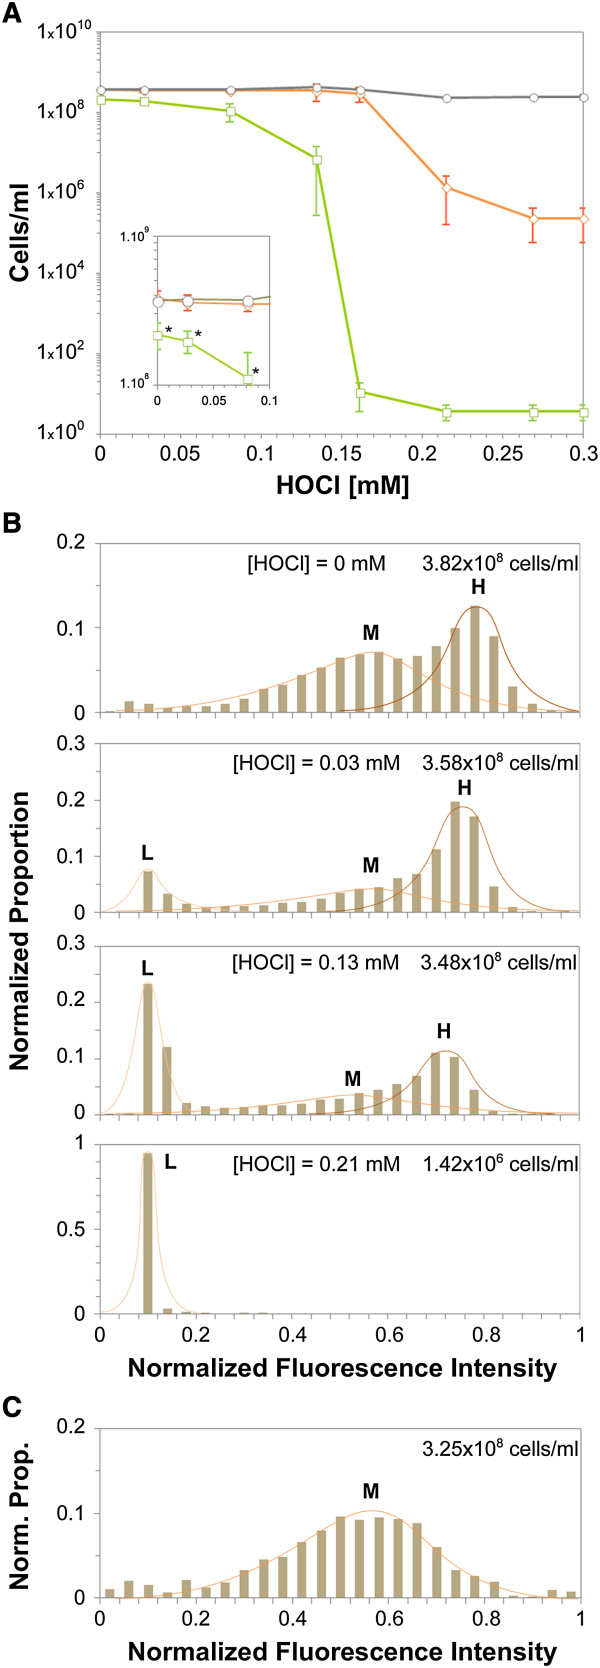
Culturability and viability of L. pneumophila Philadelphia cells harvested at the beginning of stationary phase, before and after HOCl treatment. (A) Number of culturable cells as assessed on the standard medium (□), total number of cells detected using DAPI procedure (○), and viable cells detected using the CV6 procedure (◊) as a function of HOCl concentration (mM). The values reported are the means of three independent experiments (Errors bars = SD). Inset shows a close-up of the part of the plot corresponding to HOCl concentrations lower than 0.1 mM. Stars indicate that the number of culturable cells was significantly lower (p < 0.05) than the total number of cells. (B) Distribution of the normalized fluorescence intensity of the viable cells detected using the CV6 procedure as a function of HOCl concentration. Subpopulations were named according to their relative fluorescence intensity: L (Low), M (Medium) and H (High). (C) Distribution of the normalized fluorescence intensity of viable cells detected using the CV6 procedure in samples harvested from a culture in the exponential growth phase. For each condition, at least 3000 cells were analyzed. Similar results were obtained in two other independent experiments.